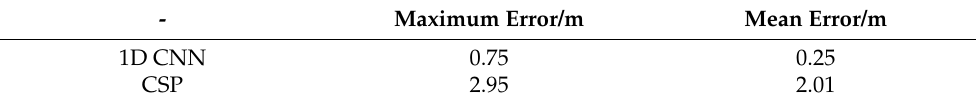
Figure 14. CDFs of estimated coordinate errors of 1D CNN and CSP schemes. Table 2. Comparison of positioning errors of 1D CNN and CSP